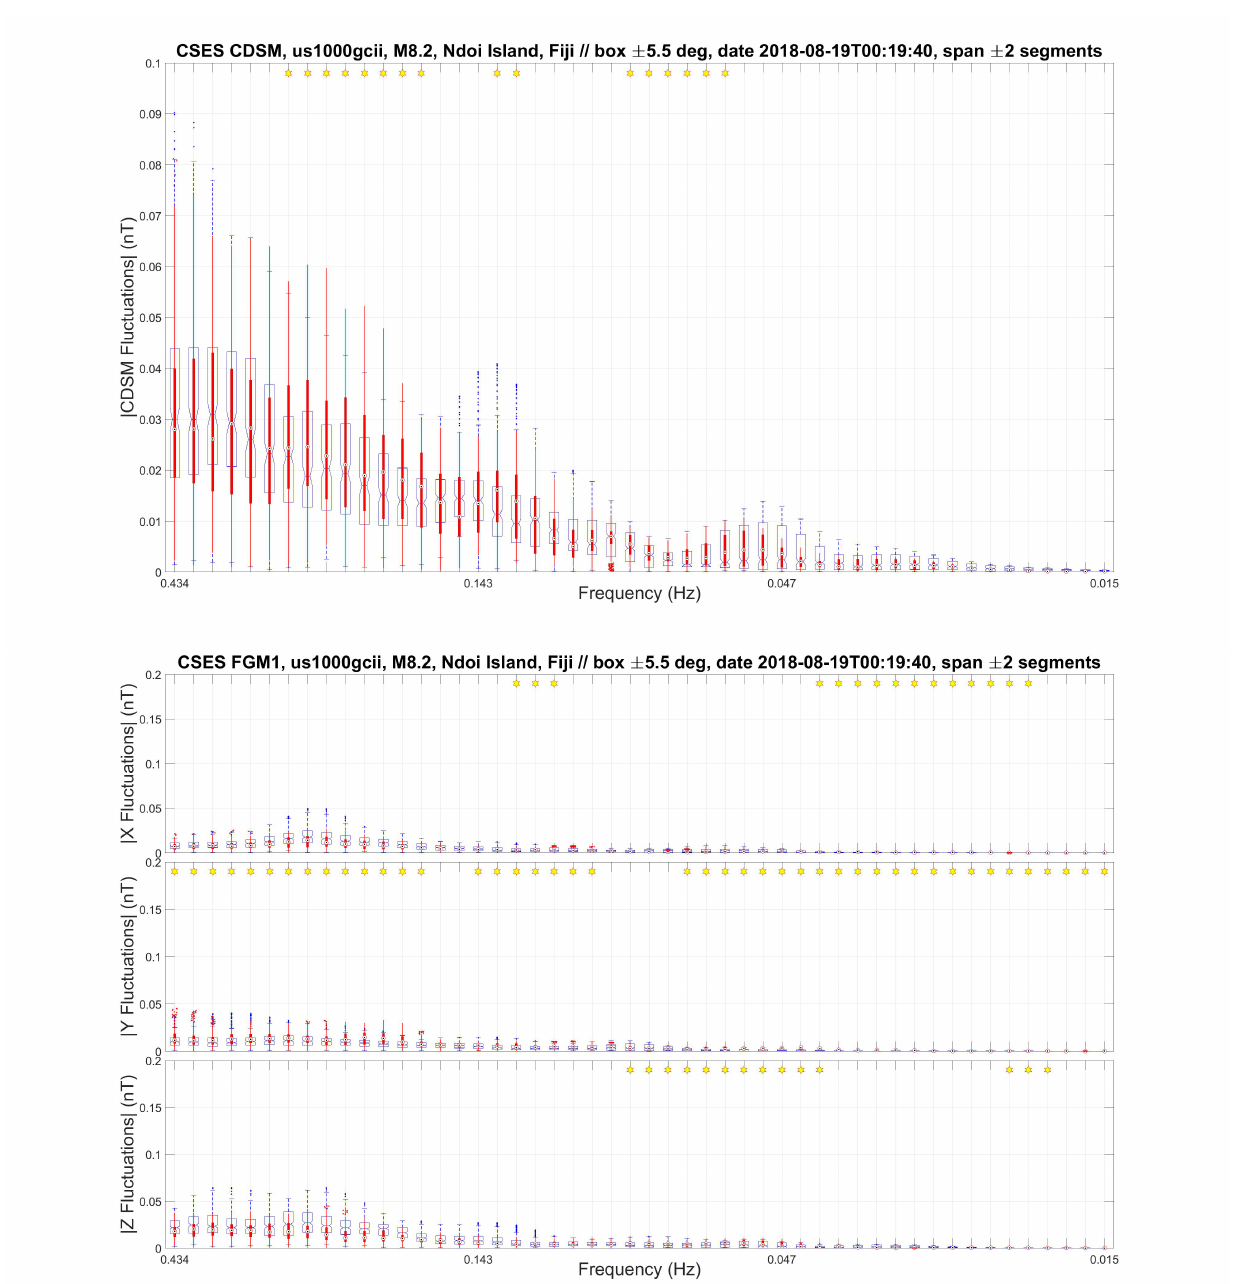
Figure 5. CSES investigation of the earthquake USGS event us1000gcii with magnitude M8.2, Ndoi Island, Fiji, focal depth 600 km, with a spatial dimension (box size) of ± 5.5 degrees, but only crossings during night times and east of the event site are considered. Top : Distribution of CSES CDSM magnetic field fluctuations grouped in individual frequency bands. The time span around the EQ is ± 2 segments, i.e., in this case ∆ t = { − 6.44, − 2.43, − 1.44, 2.57, 3.55} days shift to the EQ at 2018-08-19T00:19:40. Bottom : Distribution of the CSES FGM1 magnetic field fluctuations after wavelet analysis. The colour coding is the same as in Figure 2, geomagnetic activity is | Dst | ≤ 37 nT for the selected time